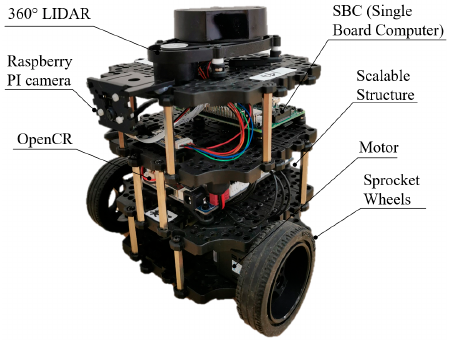
Figure 13. The TurtleBot3 Burger.